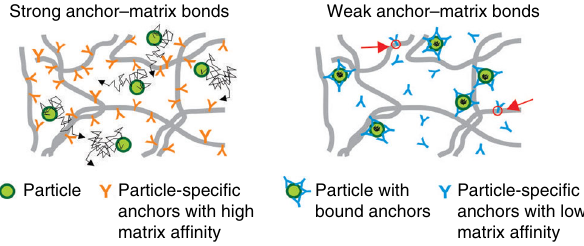
Fig. 7 Schematic of proposed mechanism. Anchors with weak and rapid interactions with the matrix can facilitate more effective crosslinking of nanoparticulates to matrix constituents compared to anchors with high- af fi nity, long-lived interactions with the matrix. The extent that the motion of nanoparticulates are hindered by different anchors are re fl ected by the dimensions of their traces ( black ). Red circles / arrows indicate the small fraction of free (not particle-bound) anchors that will transiently interact with the matrix at any moment in